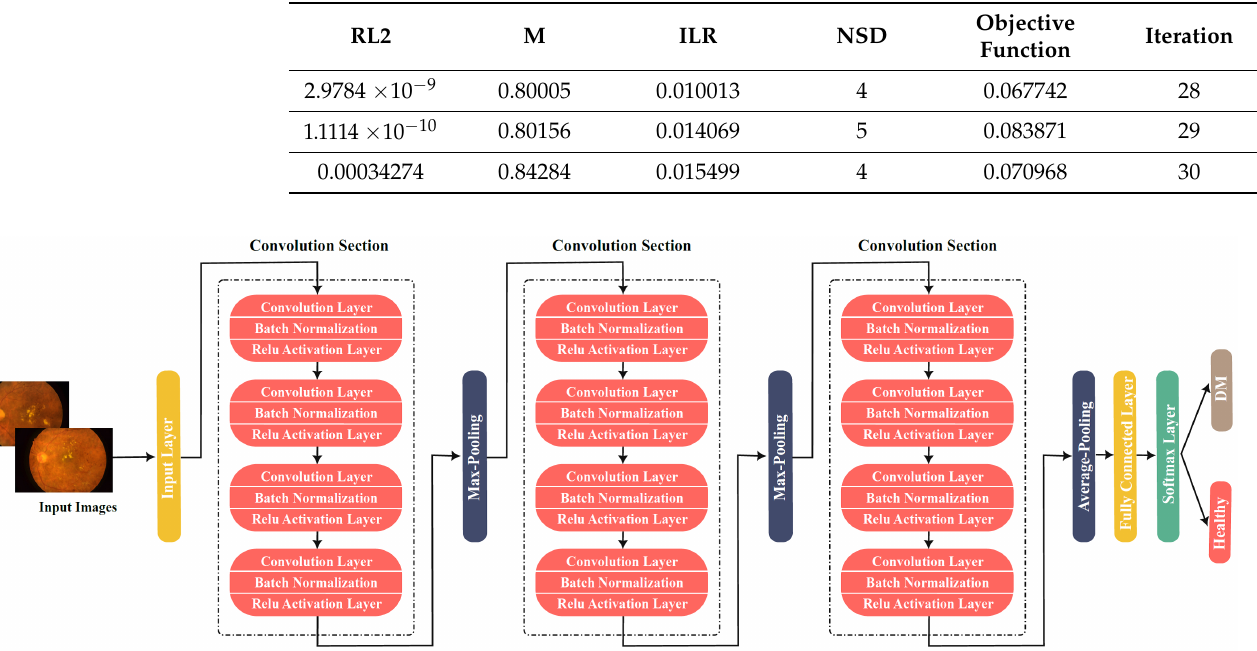
Figure 7. The optimal design of the DLN in Experiment